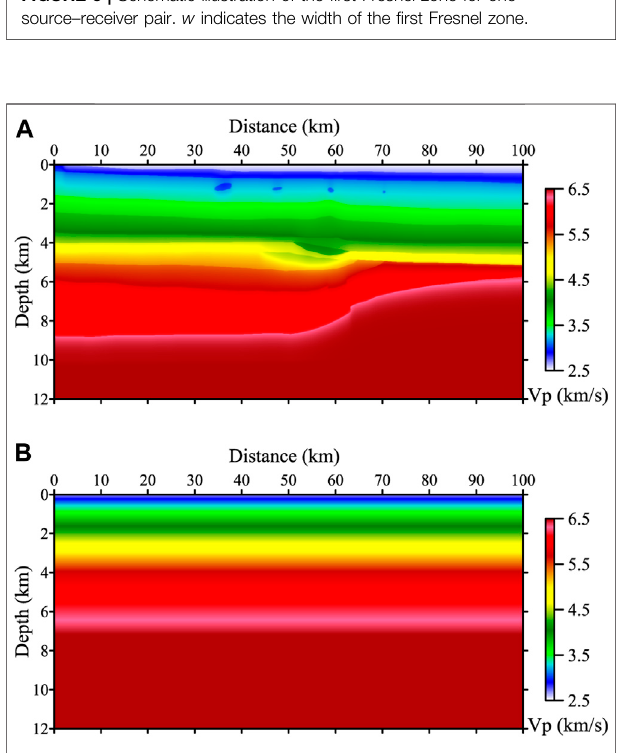
FIGURE 6 | The velocity models for the numerical test. (A) The true velocity model. (B) The initial velocity model for velocity model building.